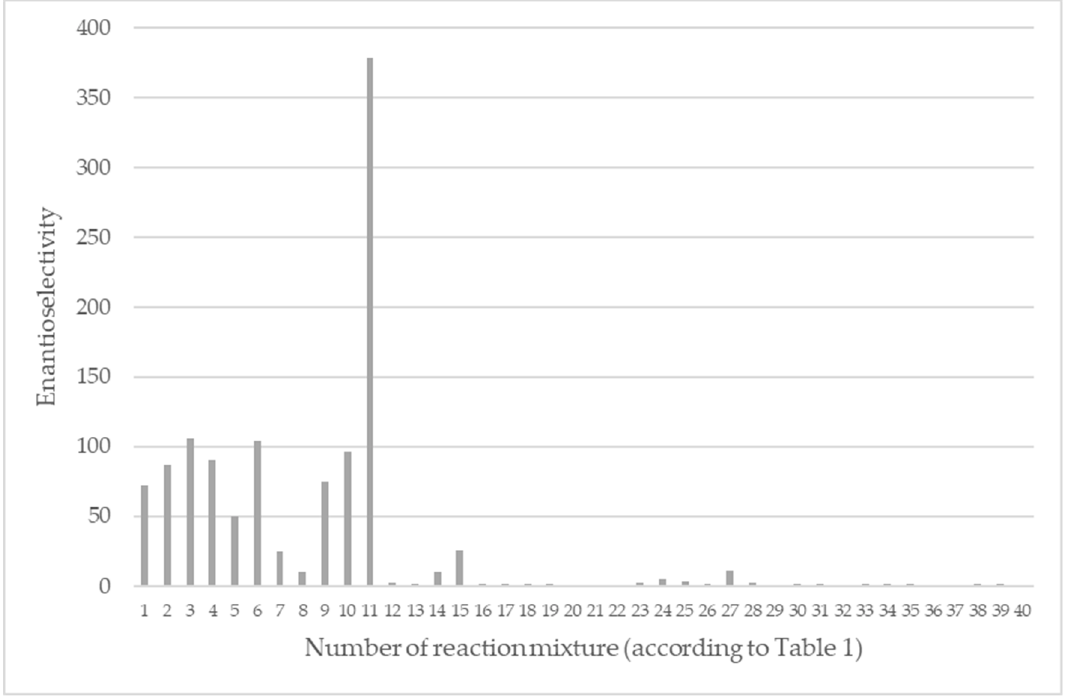
Figure 7. Enantioselectivity values of the assayed enzymatic transesterifications of ( R , S )-1-phe- nylethanol after 168 h of incubation.